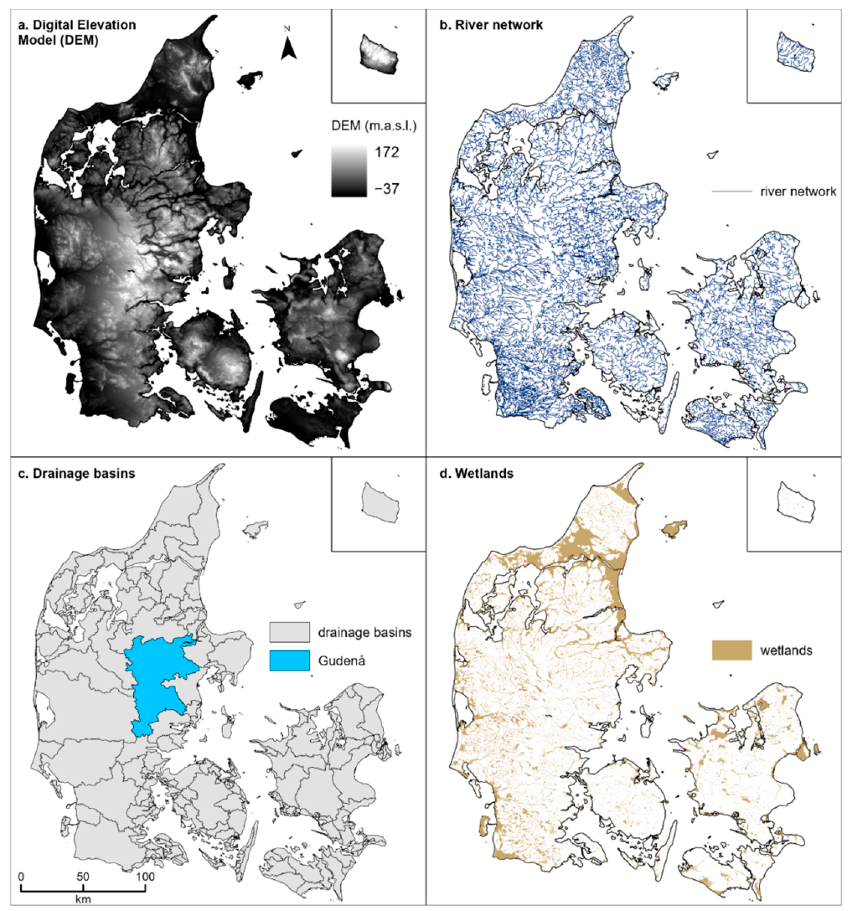
Figure 4. Spatial data used to develop the river valley bottom delineation tool consisting of ( a ) Digital Elevation Model (DEM) in meters above sea level (m.a.s.l), ( b ) river network, ( c ) drainage basins (highlighted is the Gudenå drainage basin located in the peninsula of Jutland, which we subsequently use to illustrate our delineation approach), and ( d ) wetlands.